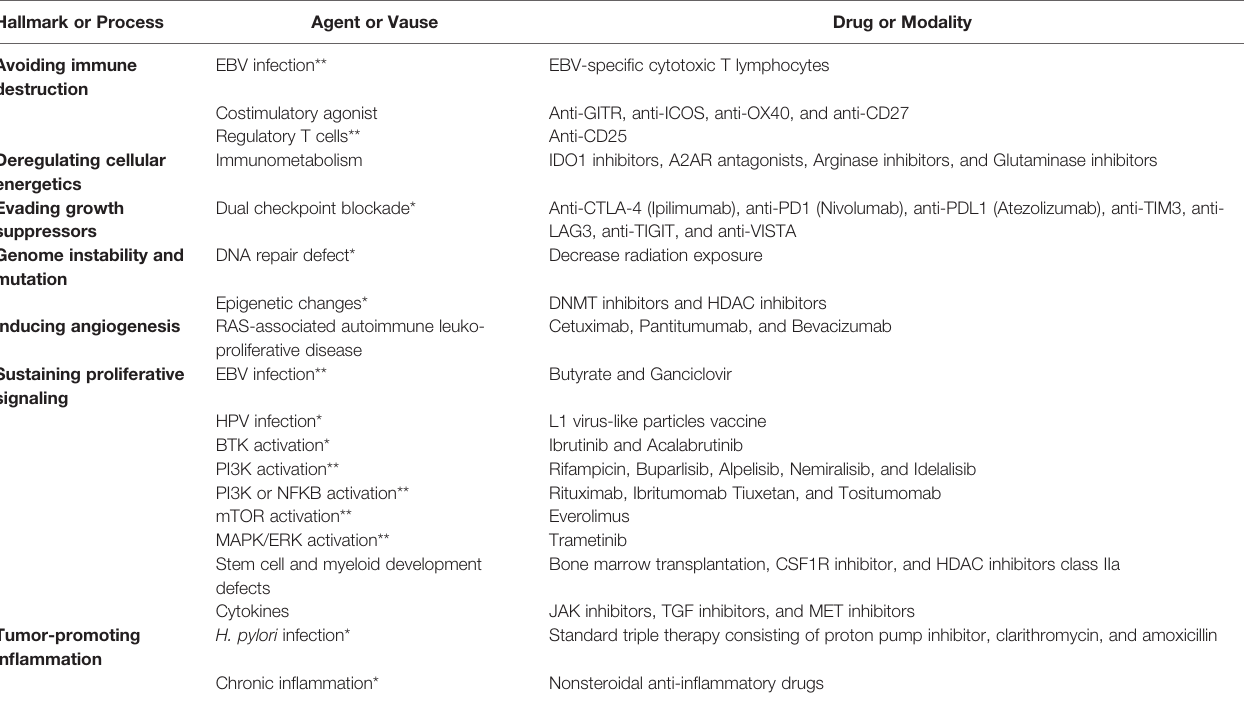
TABLE 1 | Therapeutic and preventive approaches successfully used or potentially can be implemented to prevent primary immunode fi ciency-associated cancer hallmarks. Hallmark or